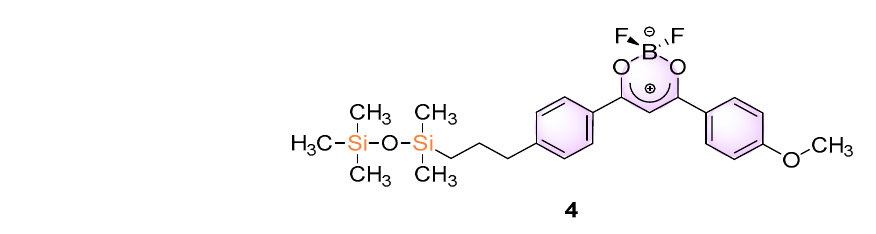
Figure 21. Model compound 4 .